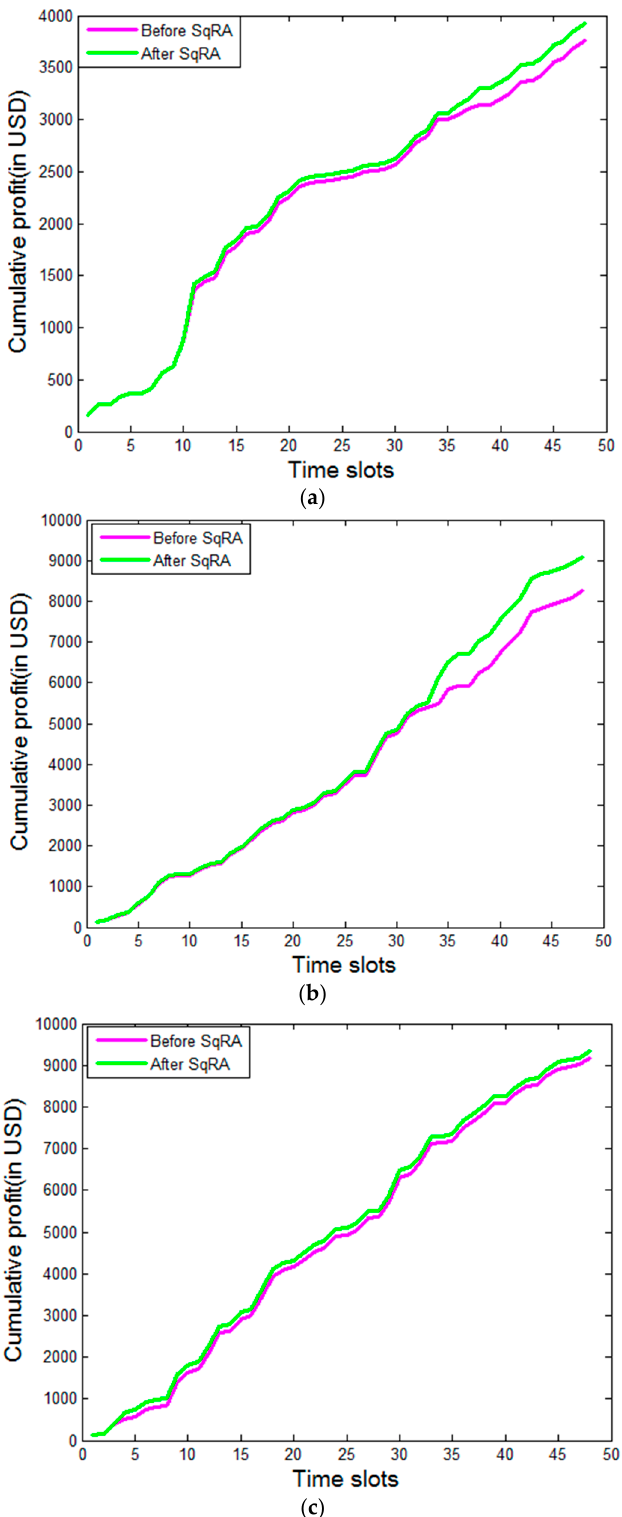
Figure 8. Profit earned by the IaaS providers over time before and after implementation of SqRA: ( a )